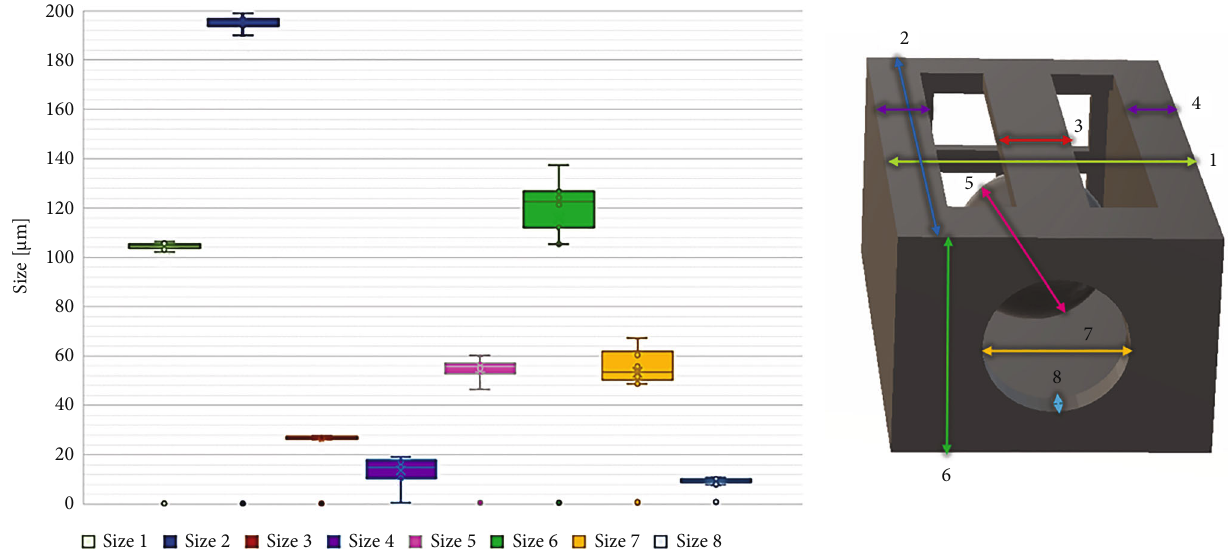
Figure 4: Measurements of di ff erent sections of the valve were recorded inside the